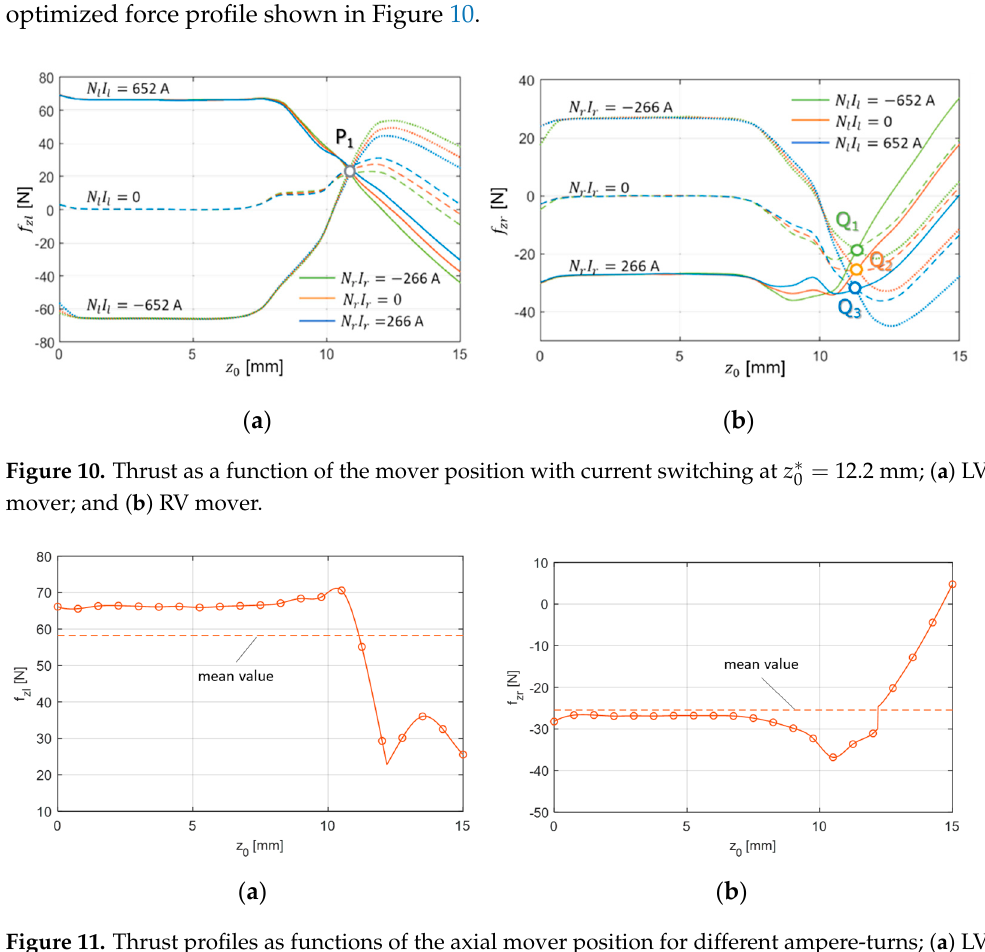
Figure 11. Thrust as a function of the mover position with current switching at 𝑧 (cid:2868)∗ = 12.2 mm; ( a ) LV mover; and ( b ) RV mover.